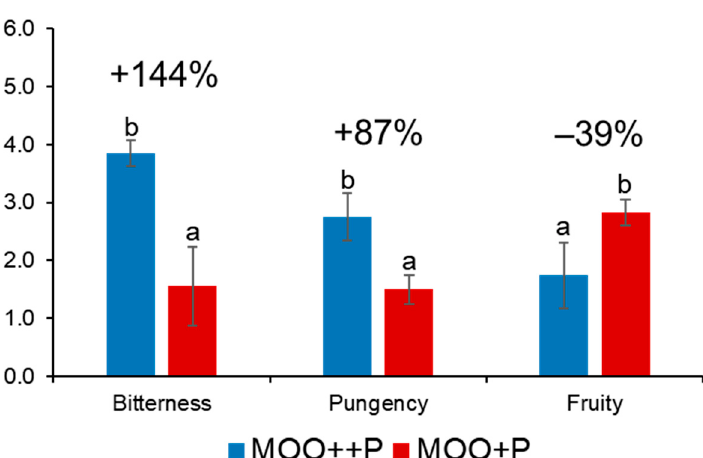
Figure 3. Sensory scores of ‘bitterness’, ‘pungency’ and ‘fruity’ attributes for all MOO samples obtained from the two panels. MOO + P code indicates the lowest level of phenolic compounds in model olive oil, while MOO ++ P is the highest level. Sensory attributes are expressed as the average of the median values obtained by using an unstructured 0–10 scale.